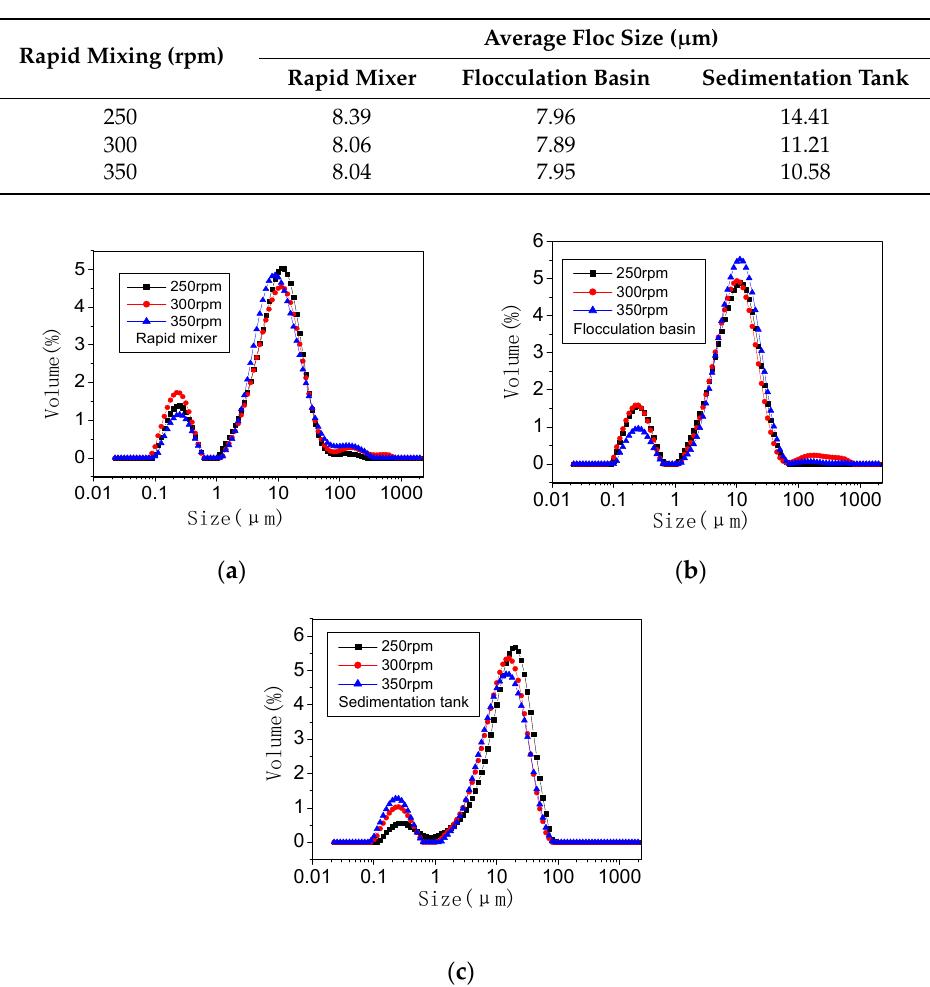
Figure 2. Floc size distribution with different rapid mixing for three stages. ( a ) rapid mixer; ( b ) flocculation basin; ( c ) sedimentation tank. Table 3. Average floc size in different process units.